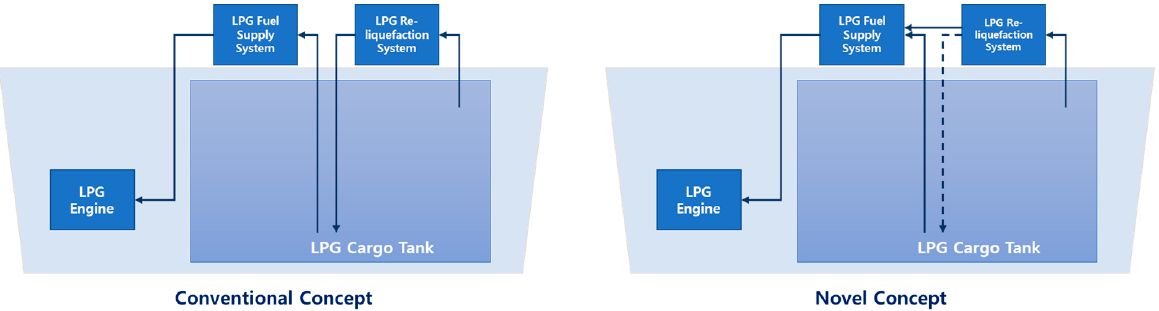
Figure 1. Configuration of re-liquefaction and fuel supply systems in conventional and novel LPG carrier.